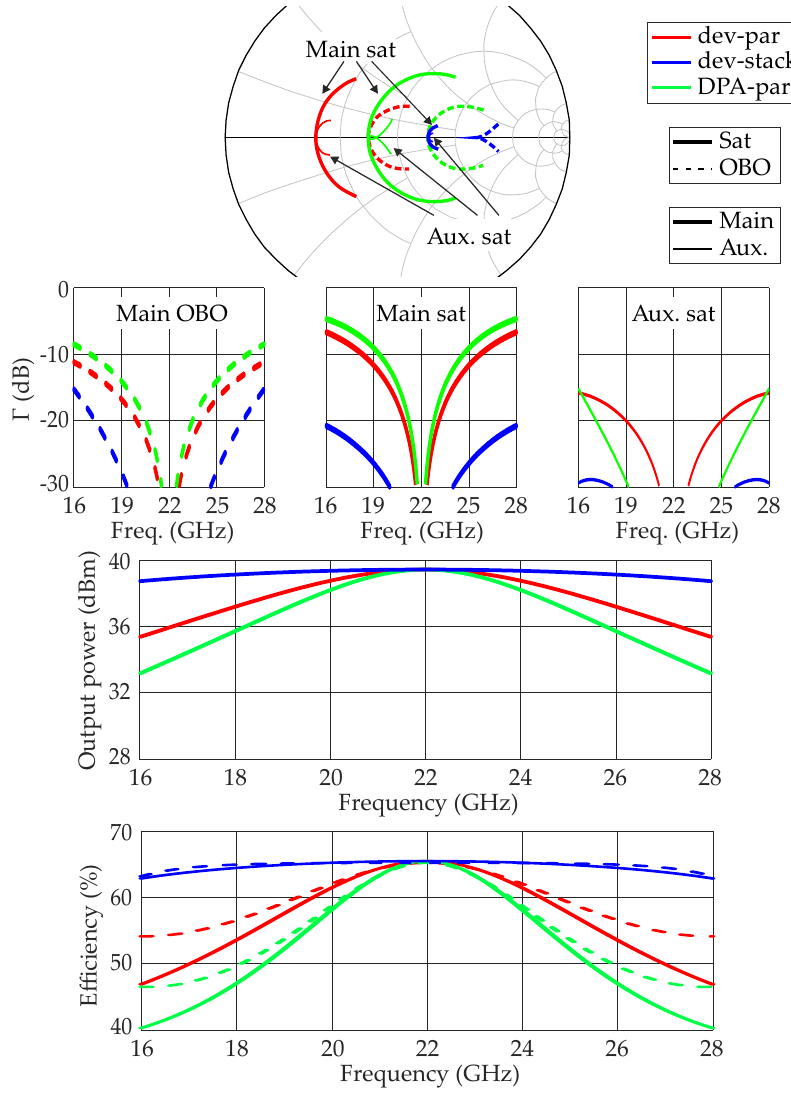
Figure 7. Comparison of the simulated frequency response, at saturation (solid) and at 6 dB back-off (dashed), of the combiner of a GaN DPA adopting different power combination strategies: parallel combination at device level (red), stacking of devices (blue), and parallel combination at DPA level (green). From top to bottom: synthesized loads at the current generator planes, saturated output power, efficiency.